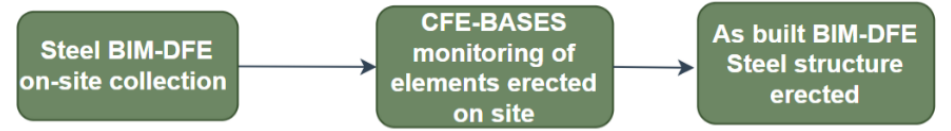
Figure 20. BIM-DFE Erection.